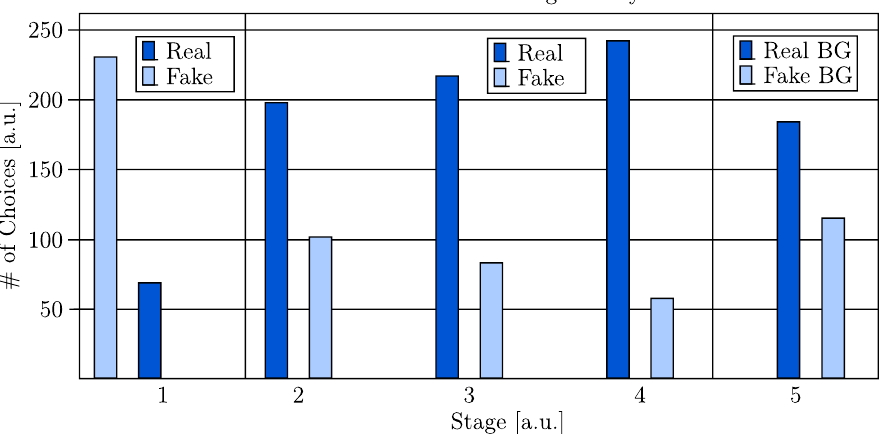
Figure 11. Quantitative results of the MTurk-like multistage survey conducted by 30 volunteers.